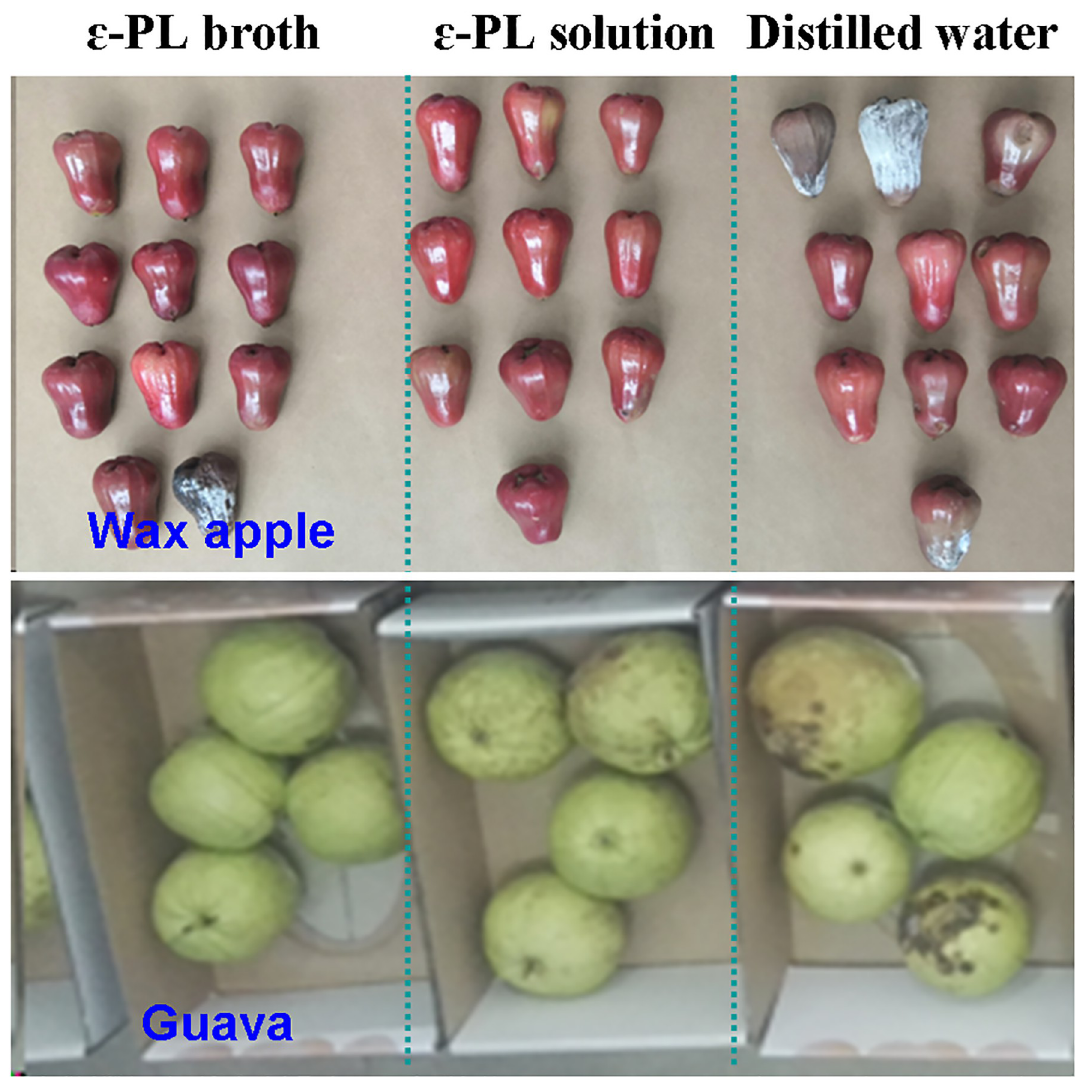
Fig 2. Visual appearance of wax apple and guava fruits with different treatments after a storage period of 7 days. ε -PL concentration was 200 mg/L in both solutions.